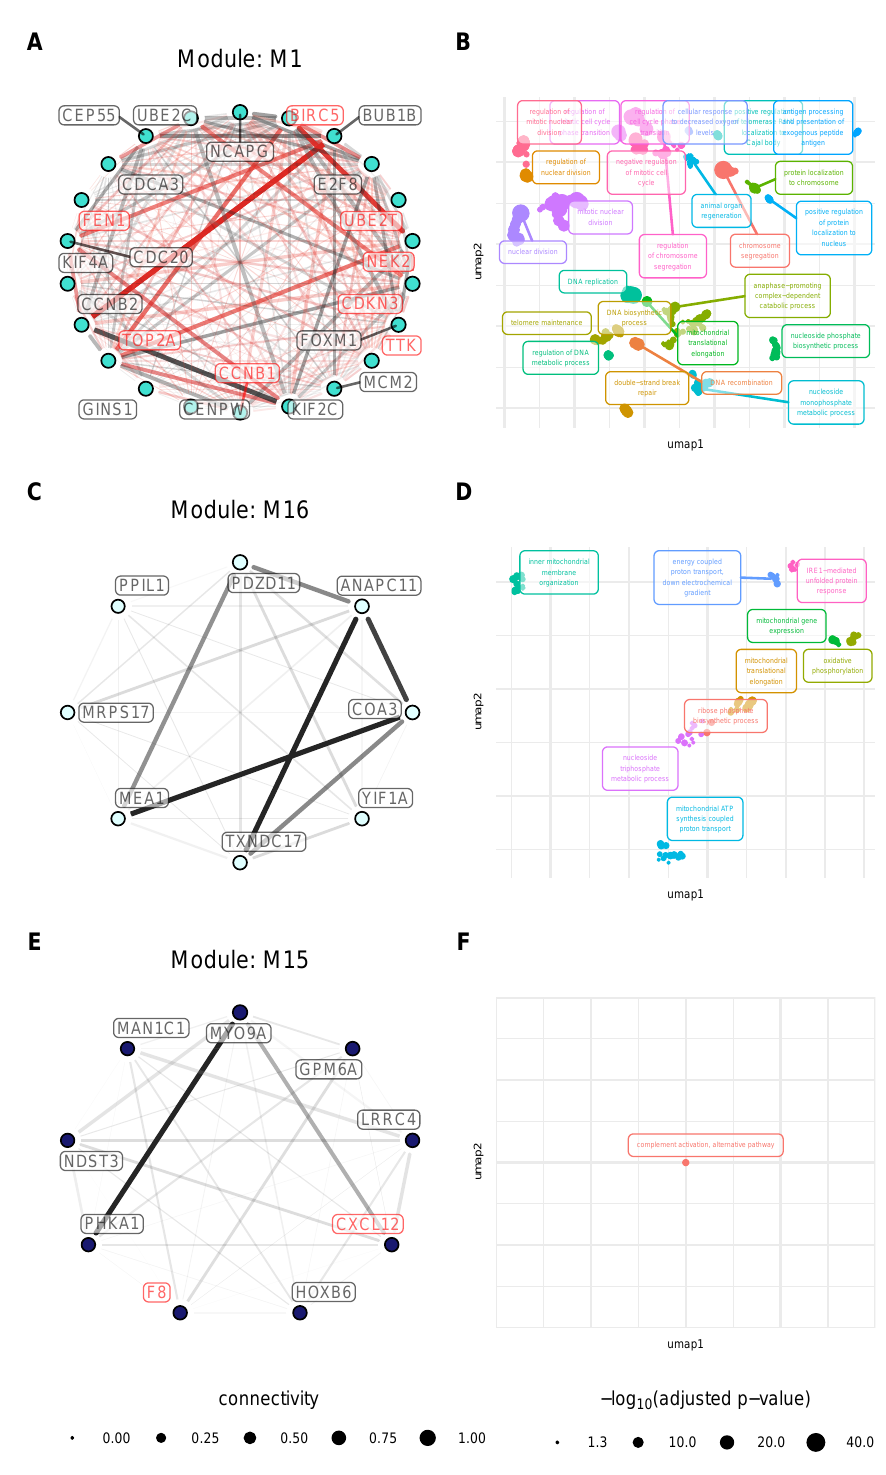
Figure 7. Network and GO Term enrichment plots the hub genes of modules with strong association to cell origin. Network plots ( A , C , E ) are coloured according to the original module color. Read labels indicate druggability, and edge thickness represents connection strengths (red indicating known FI). GO term Enrichment plots ( B , D , F ) are coloured according to term clusters and labelled with the most significant term of the respective